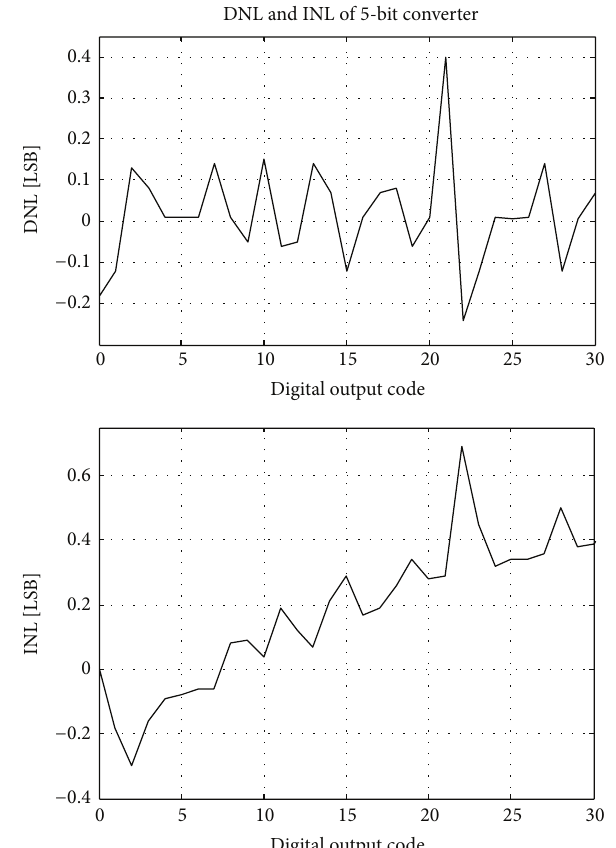
Figure 11: DNL and INL of flash